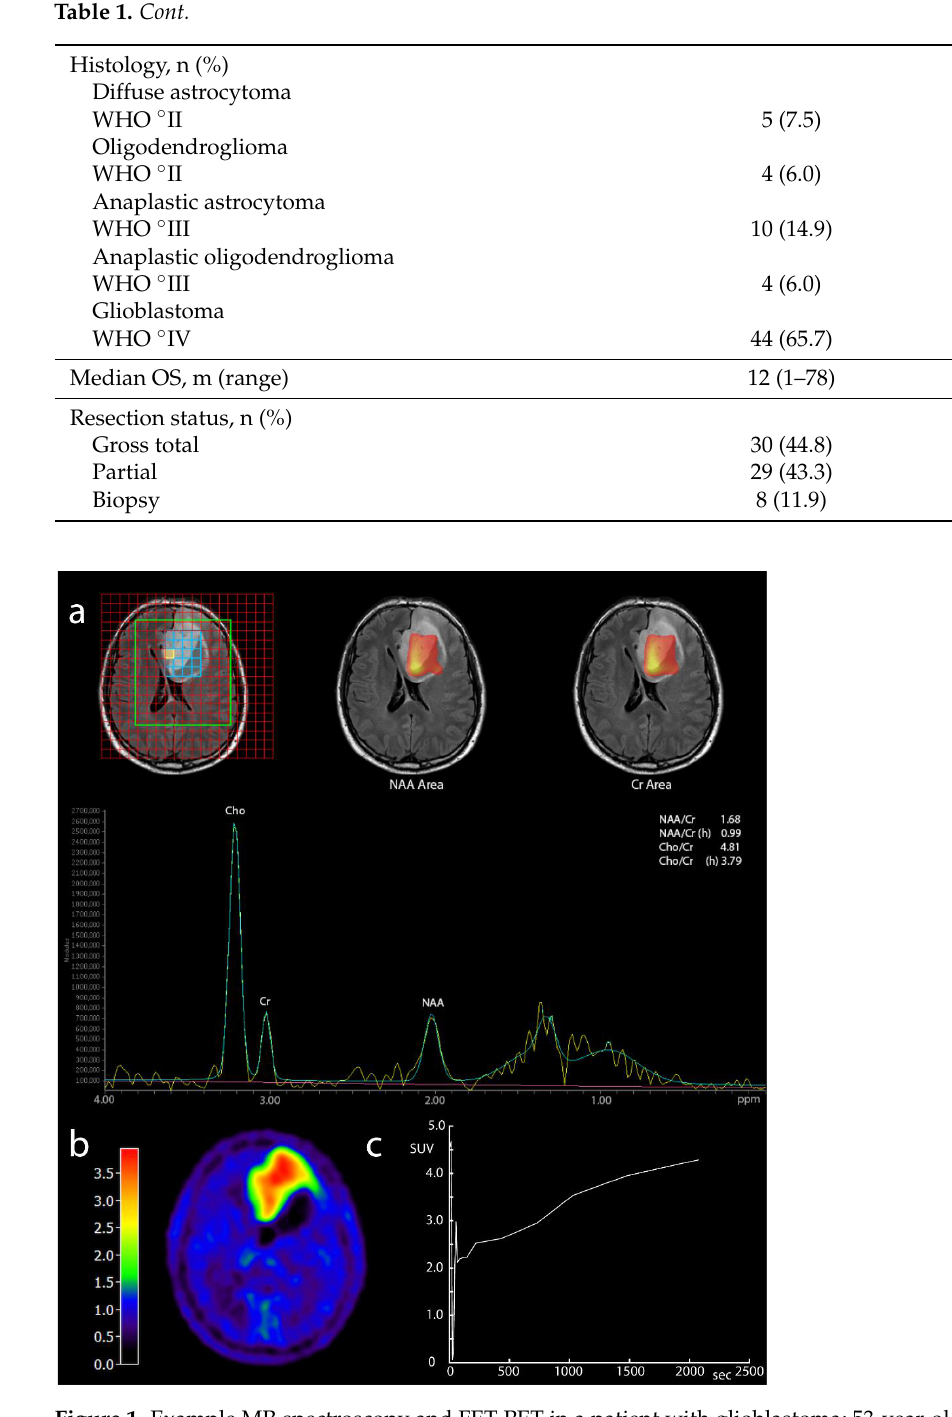
Figure 1. Example MR spectroscopy and FET-PET in a patient with glioblastoma; 53-year-old patient with untreated left frontal glioblastoma (WHO grade IV). ( a ) Multi-voxel 1H-MRS with spectroscopy grid and representative spectrum from a tumor voxel with signal intensities and ratios for Cho, Cr, and NAA, showing an elevated Cho/Cr ratio. Yellow line — unsmoothed, green line — smoothed values, purple - baseline. ( b ) Static FET-PET scan 30 min after injection with intense tracer enhancement (TBR 3.5). ( c ) Dynamic FET-PET over 40 min shows a linearly ascending activity slope in the tumor, untypical for glioblastoma. Interestingly, this patient had an unusual benign course with one relapse but long-term survival over several years and no further recurrence so